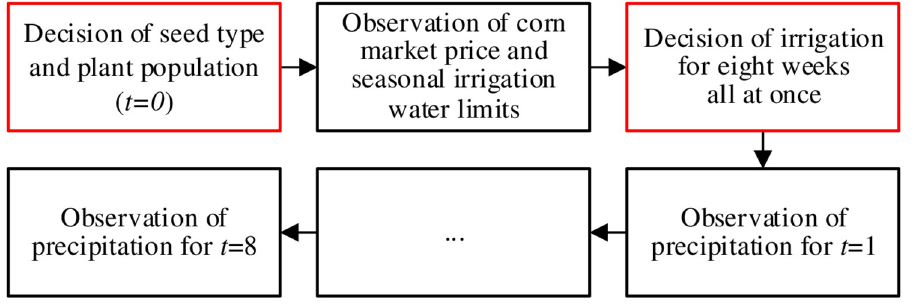
Fig 3. The detailed decision process for two-stage stochastic